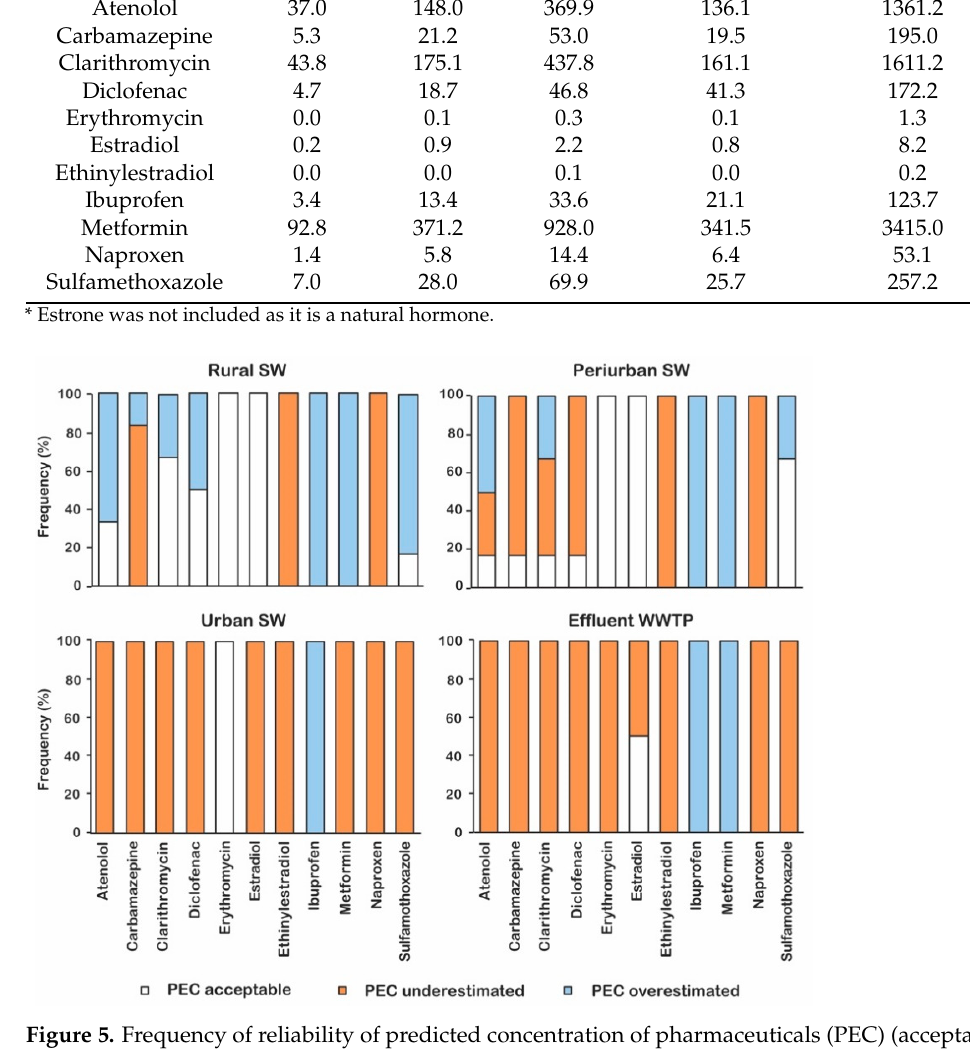
Figure 5. Frequency of reliability of predicted concentration of pharmaceuticals (PEC) (acceptable, overestimated, and underestimated) based on the logarithm of the ratio between PEC calculated by the refined formula and measured concentration of pharmaceuticals (MEC) (average of all concen- trations measured in both sampling campaigns) in SwRur, SwPurb, SwUrb, and EffWWTP (SwRur: rural area; SwPurb: periurban area; SwUrb: urban area; EffWWTP: effluent of the wastewater treat- ment plant).